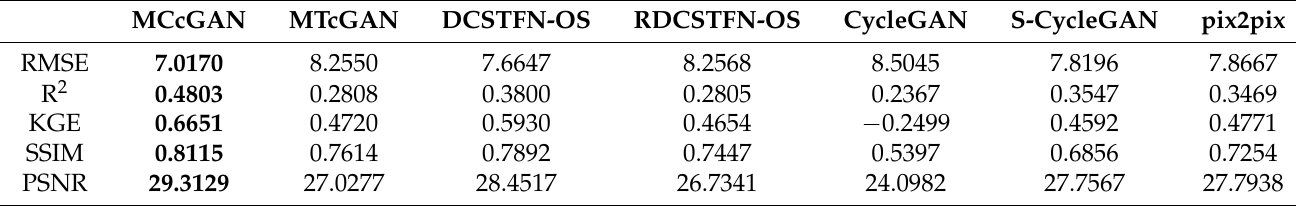
Table A5. The evaluation metrics of different methods for the green band in Area B at Time IV (the bold result is the best among the different metrics).